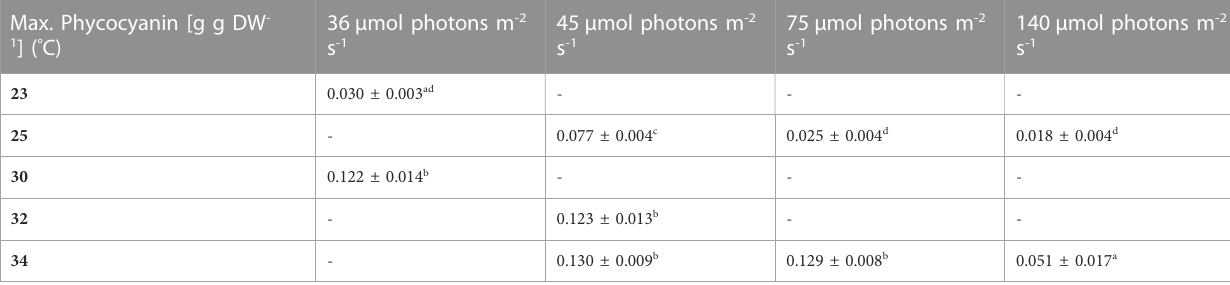
TABLE 7 Maximum phycocyanin content. The values are shown as mean ± SD of four to eight cultures. Max. Phycocyanin [g g DW - 1 ] ( °